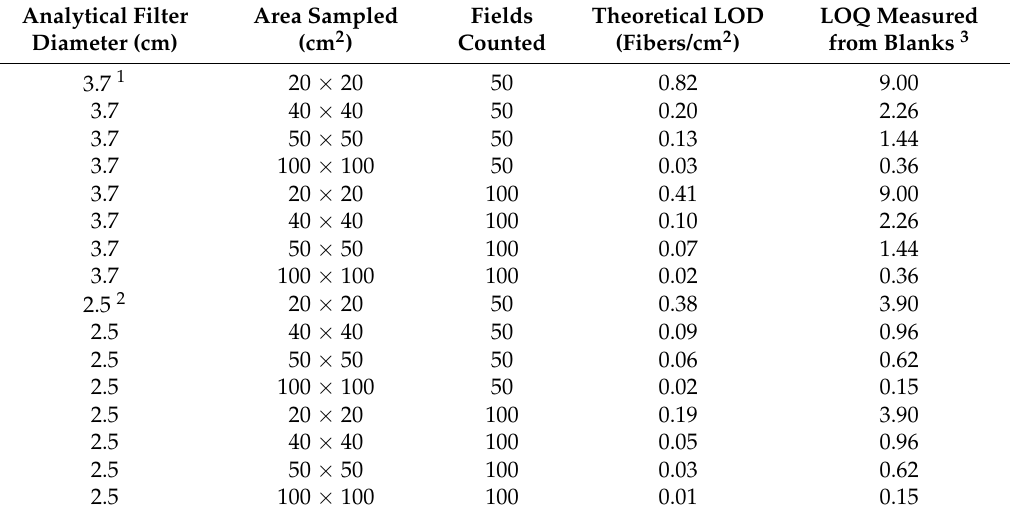
Table 2. Limits of detection (LODs) and quantitation (LOQ) of the filter cassette method. Analytical Filter Diameter